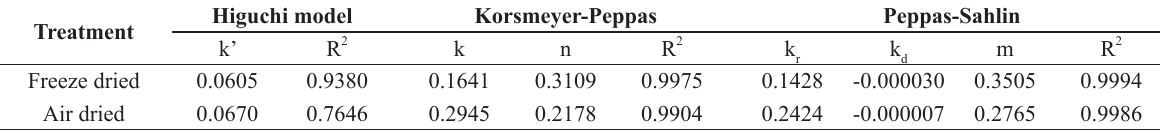
Water absorption model parameters for air (ADH) and freeze dried (FDH) gelatin hydrogels using Higuchi, Korsmeyer- Peppas, and Peppas-Sahlin Equations.